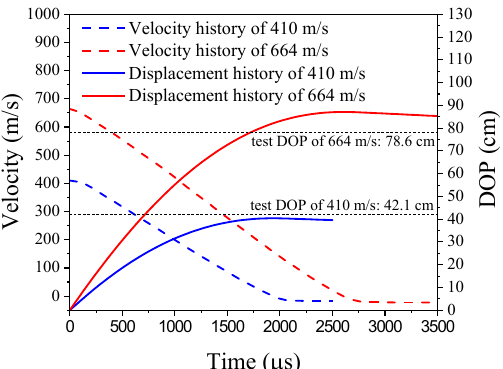
Figure 17. Velocity and displacement histories of projectiles at striking velocities of 410 m/s and 664 m/s.